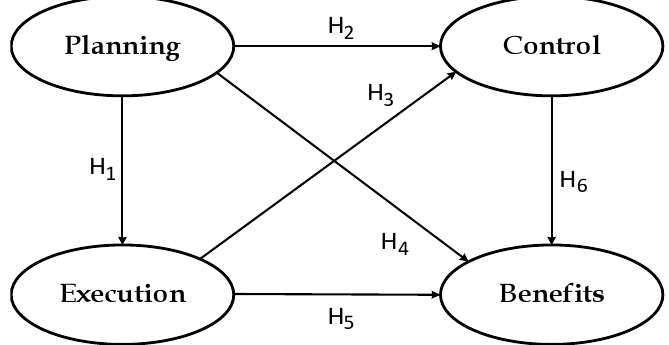
Figure 1. Hypotheses for ICT implementation in SC.